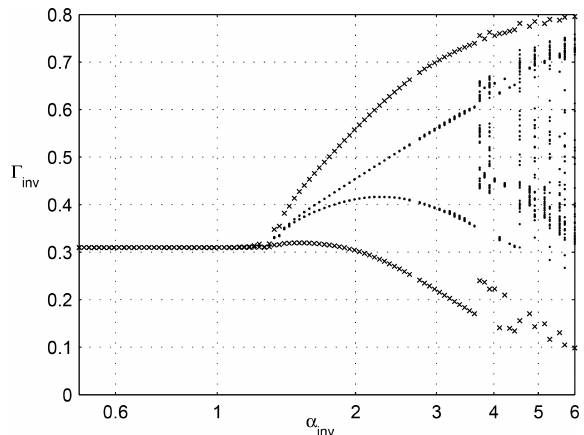
Figure 5. Bifurcation diagram of a nonequilibrium dynamical model (NEDyM), showing its transitions from equilibrium to purely periodic and on to chaotic behavior. The investment parameter α inv is on the abscissa, and the investment ratio (cid:48) inv is on the ordinate. The model has a unique, stable equilibrium for low values of α inv , with (cid:48) inv (cid:39) 0 . 3. A Hopf bifurcation occurs at α inv (cid:39) 1 . 39, leading to a limit cycle, followed by transition to chaos at α inv (cid:39) 3 . 8. The crosses indicate first the stable equilibrium and then the orbit’s min- ima and maxima, while dots indicate the Poincaré intersections with the hyperplane, H = 0, when the goods inventory, H , vanishes. Re- produced from Groth et al. (2015a), with permission from AGU